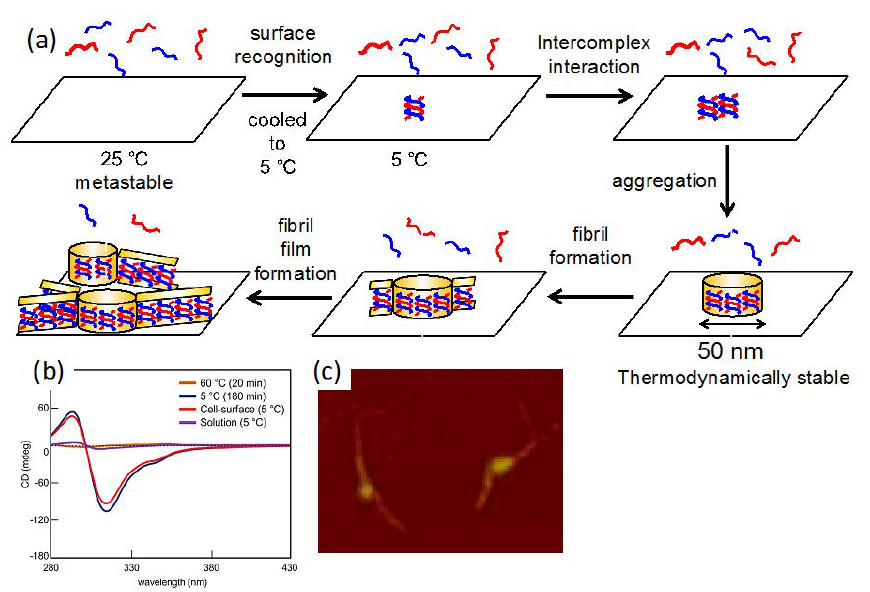
Figure 29. ( a ) Schematic presentation of fibril film formation shown by ( b ) CD spectra and ( c ) AFM